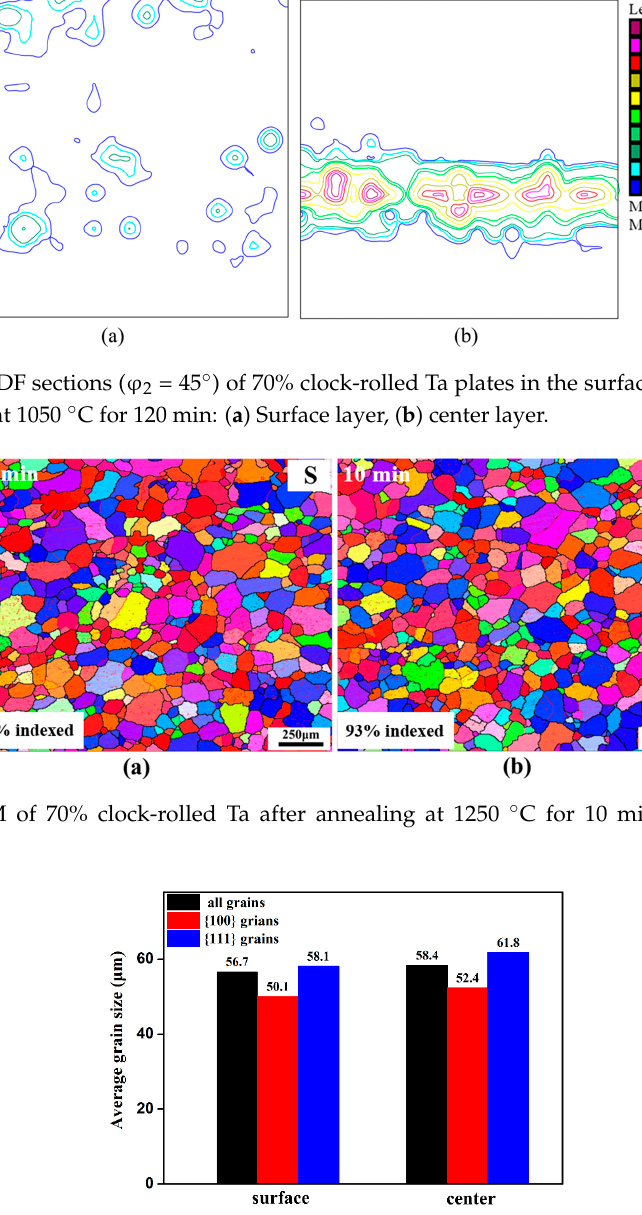
Figure 11. Average grain size of 70% clock-rolled Ta when annealed at 1250 °C for 10 min.